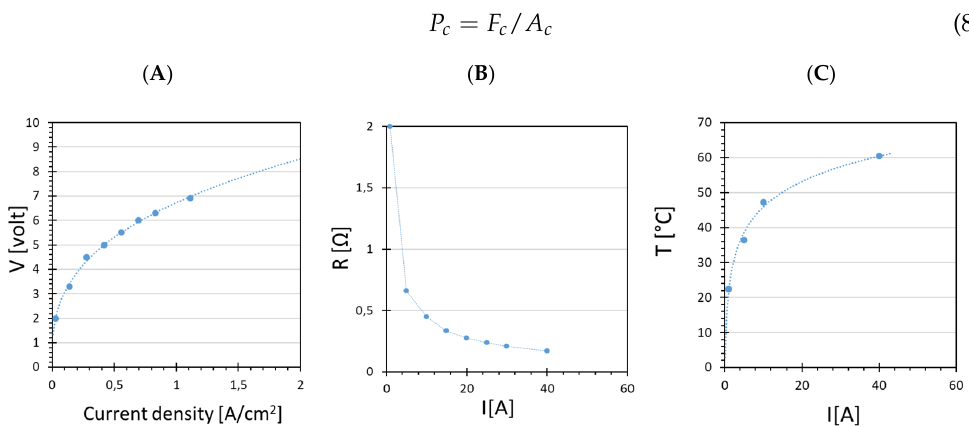
Figure 7. ( A ) Polarization curve for the Ir-Pt-Nafion™ 117 CCM electrolyzer test; ( B ) resistance of the system as function of the current; ( C ) temperature increase as function of the current.